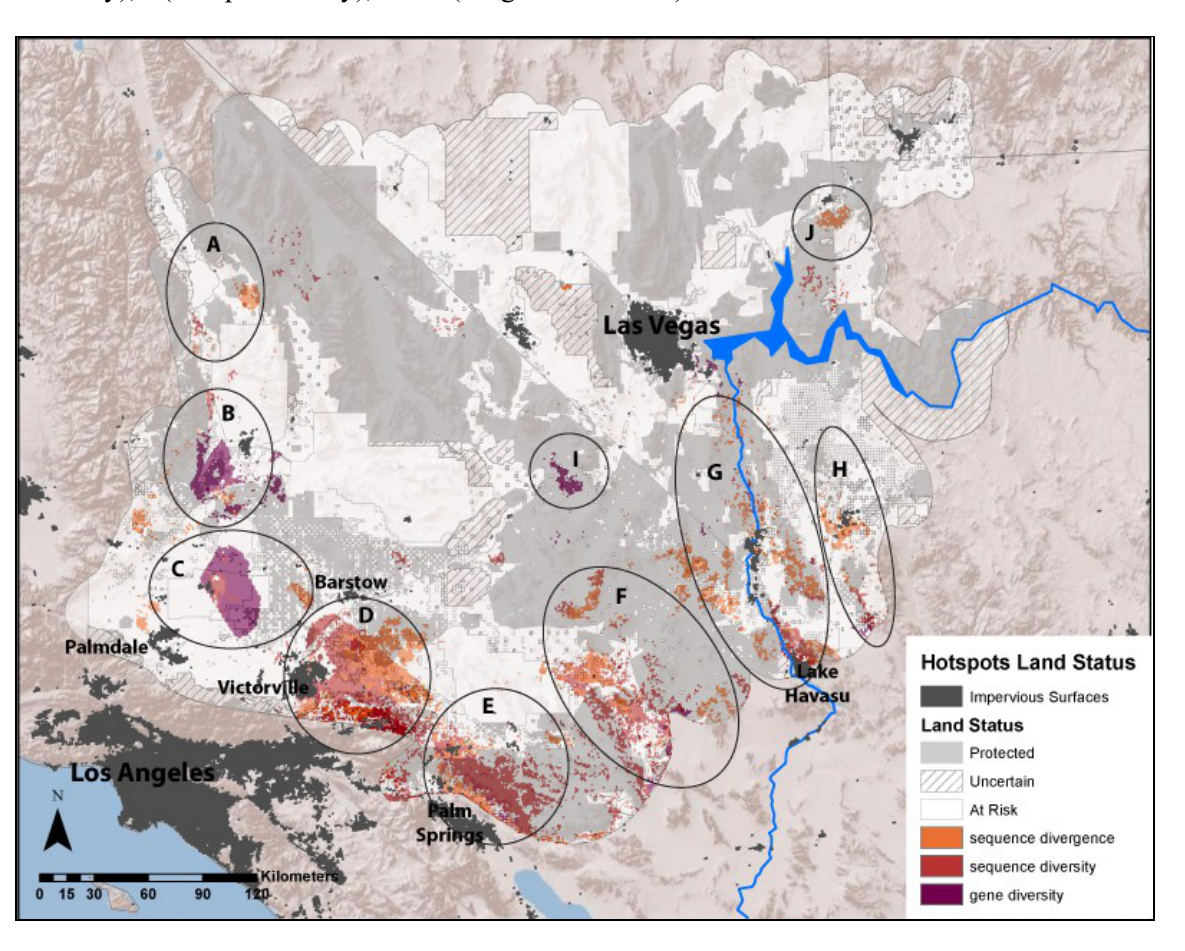
Figure 3. Ten regional hotspots of sequence divergence, sequence diversity and gene diversity with relation to land conservation status in the Mojave Desert. Hotspots are A (Dunmovin–Coso Junction), B (Sierra–Tehachapi Transition Zone), C (Antelope Valley– Mojave Desert Transition), D (Ord Mountain–Lucerne Valley), E (Indio Hills–Little San Bernardino Mountains), F (Pluvial Lakes), G (Colorado River), H (Sacramento–Detrital Valley), I (Ivanpah Valley), and J (Virgin